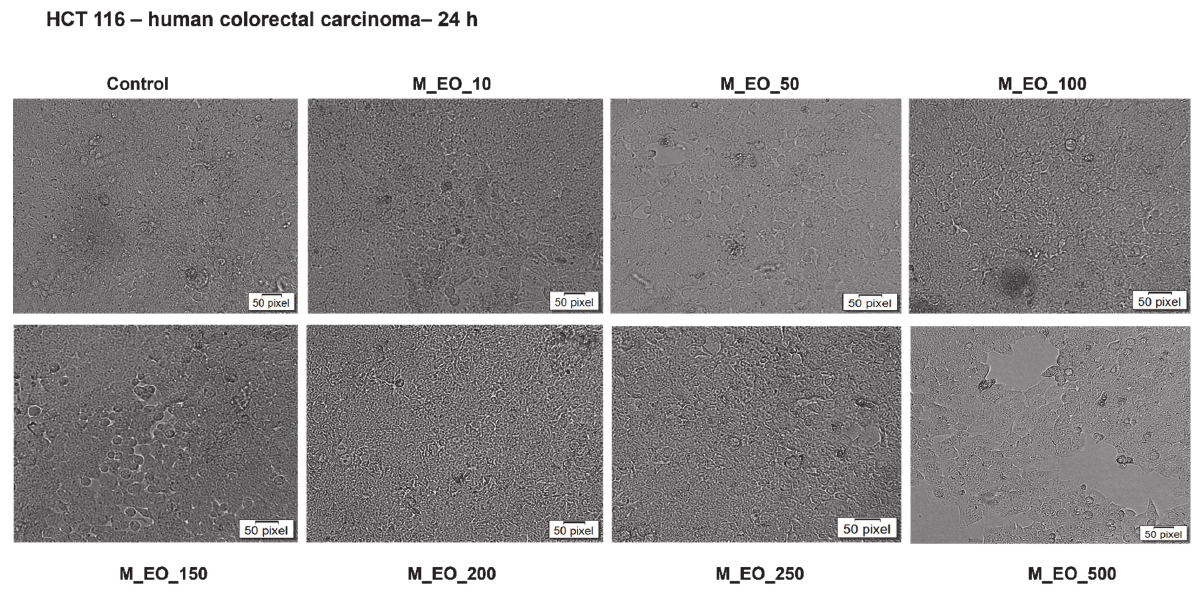
Figure 2 . Morphological aspect of HCT 116 cells after treatment for 24 h with Mentha piperita L. essential oil—M_EO (10, 50, 100, 150, 200, 250 and 500 μ g/mL). Based on data from cell viability test and cells’ morphology evaluation, it was verified if the cytotoxic signs induced by M_EO treatment were specific for apoptosis or necrosis by the means of Hoechst staining (Figure 3). The concentrations selected for this experiment were the lowest—10 μ g/mL and the concentration responsible for the first signs of cytotoxicity—150 μ g/mL. The nuclei of the HCT 116 cells were not affected by the lowest concentration of M_EO presenting a round shape similar to control cells, still the 150 µ g/mL concentration triggered some apoptotic specific signs (nuclear shrinking and fragmentation—yellow arrows) as the ones described for Staurosporine solution (control positive for apoptosis). No signs of necrosis were detected in the groups of cells incubated with M_EO, as seen in cells exposed to Triton X ‐ 100 solution (control positive for necrosis) (Figure 3).